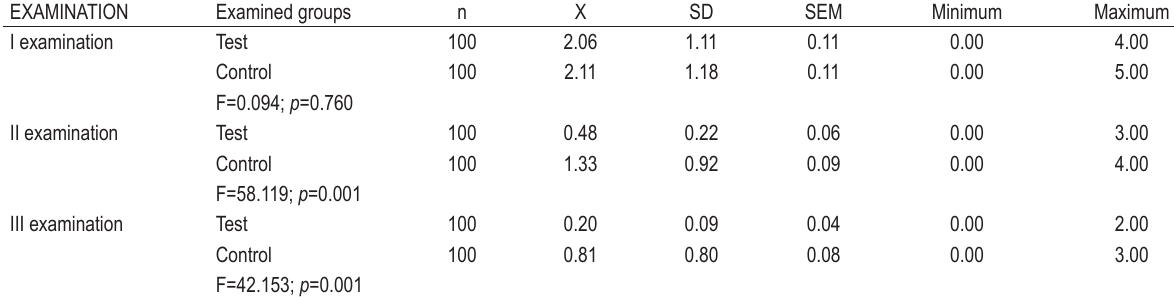
TABLE 5. Analysis of the ability to maintain a sitting position in both examined groups